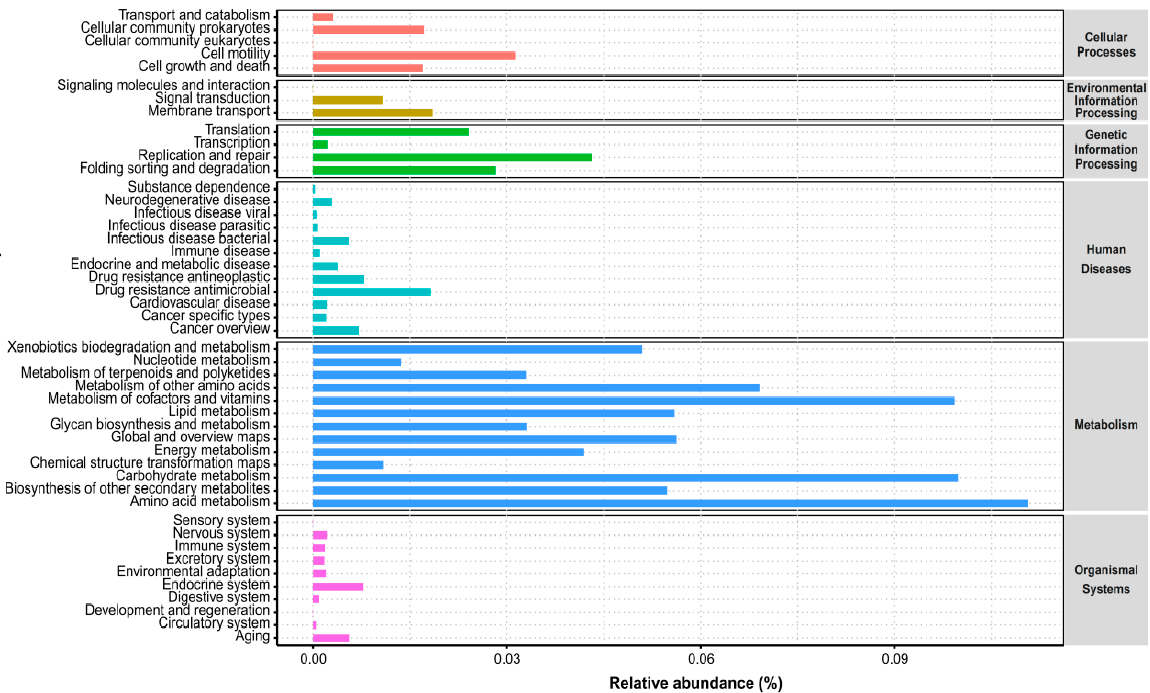
Figure 5. Bacterial gene functions were predicted from 16S rRNA gene ‐ based microbial composi ‐ tions using the PICRUSt2 algorithm to make inferences from KEGG annotated databases. using the PICRUSt2 algorithm to make inferences from KEGG annotated